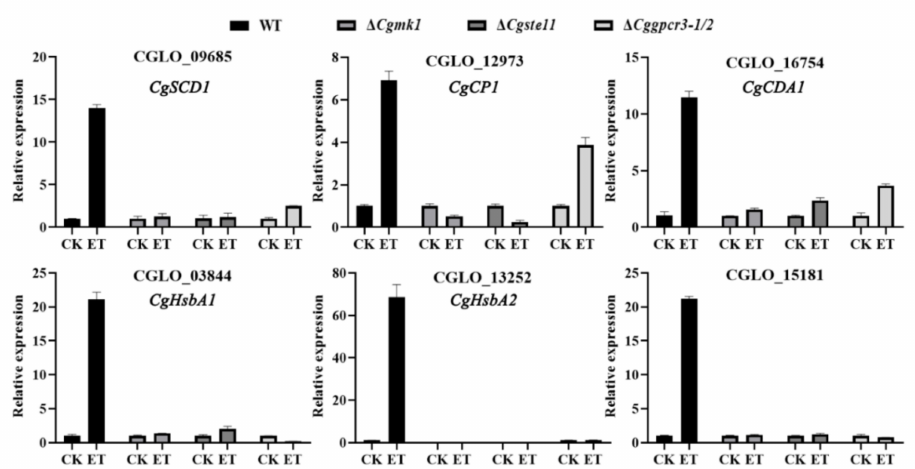
Figure 8. Comparative expression analysis of the ET-induced genes in the WT and ∆ Cgmk1 , ∆ Cgste11 , and ∆ Cggpcr3-1 / 2